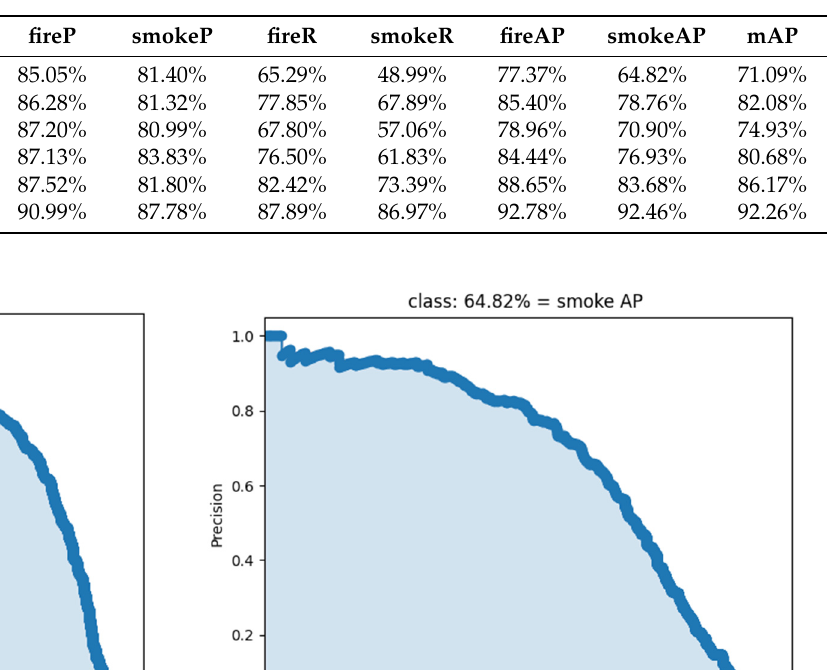
Table 4. Comparison of evaluation indexes of different models.